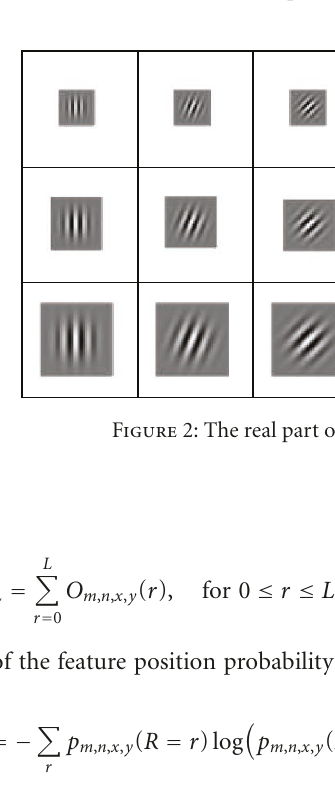
Figure 1: Overall process of the proposed facial expression recognition method.